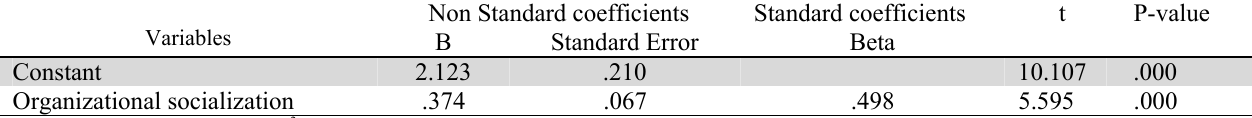
Result of linear regression analysis of Organizational socialization and Career aspiration intention Non Standard coefficients Standard coefficients Variables